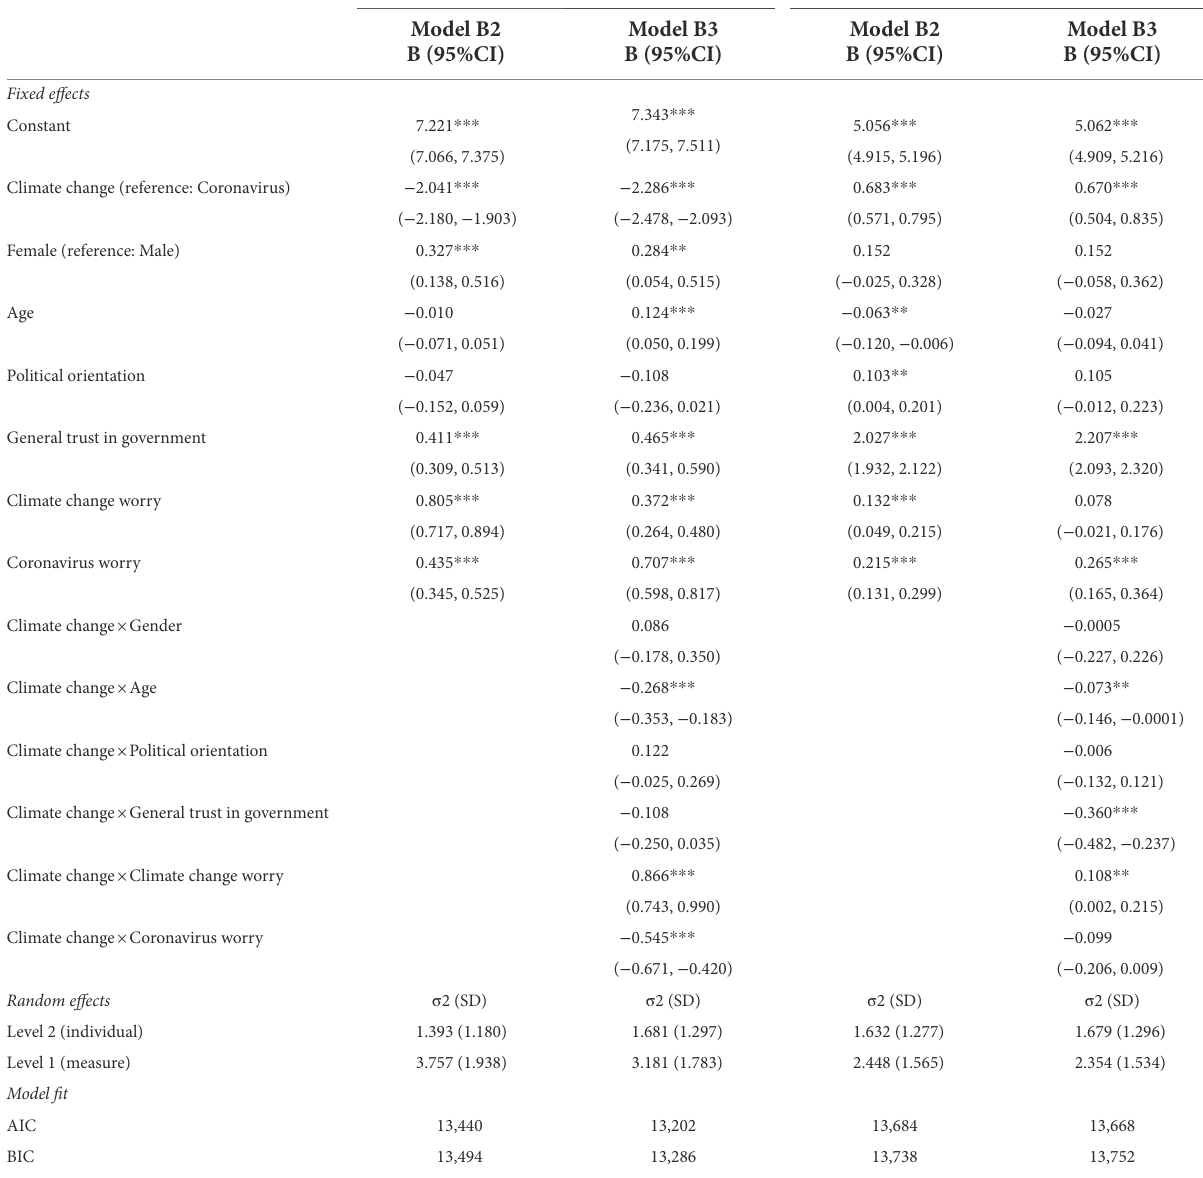
TABLE 4 Perceived personal efficacy and government trust (Models B2 and